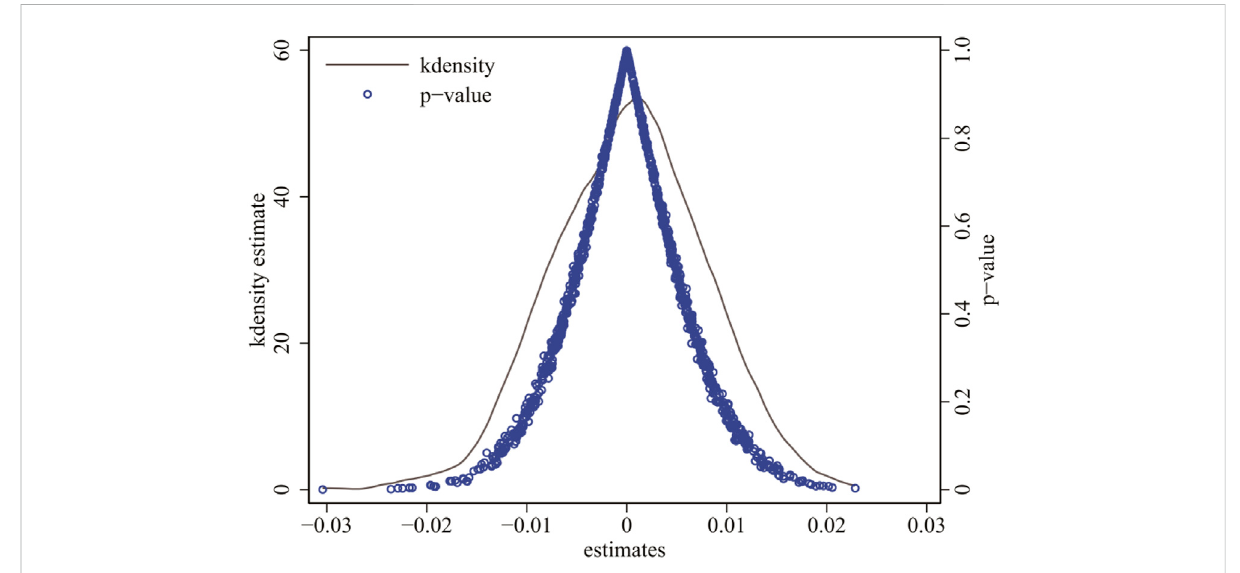
FIGURE 2 Placebo test. (PS: Figure is the plot of kernel density and p -value distribution of coef fi cients estimated with random sample 1,000 times based on the benchmark estimation.)